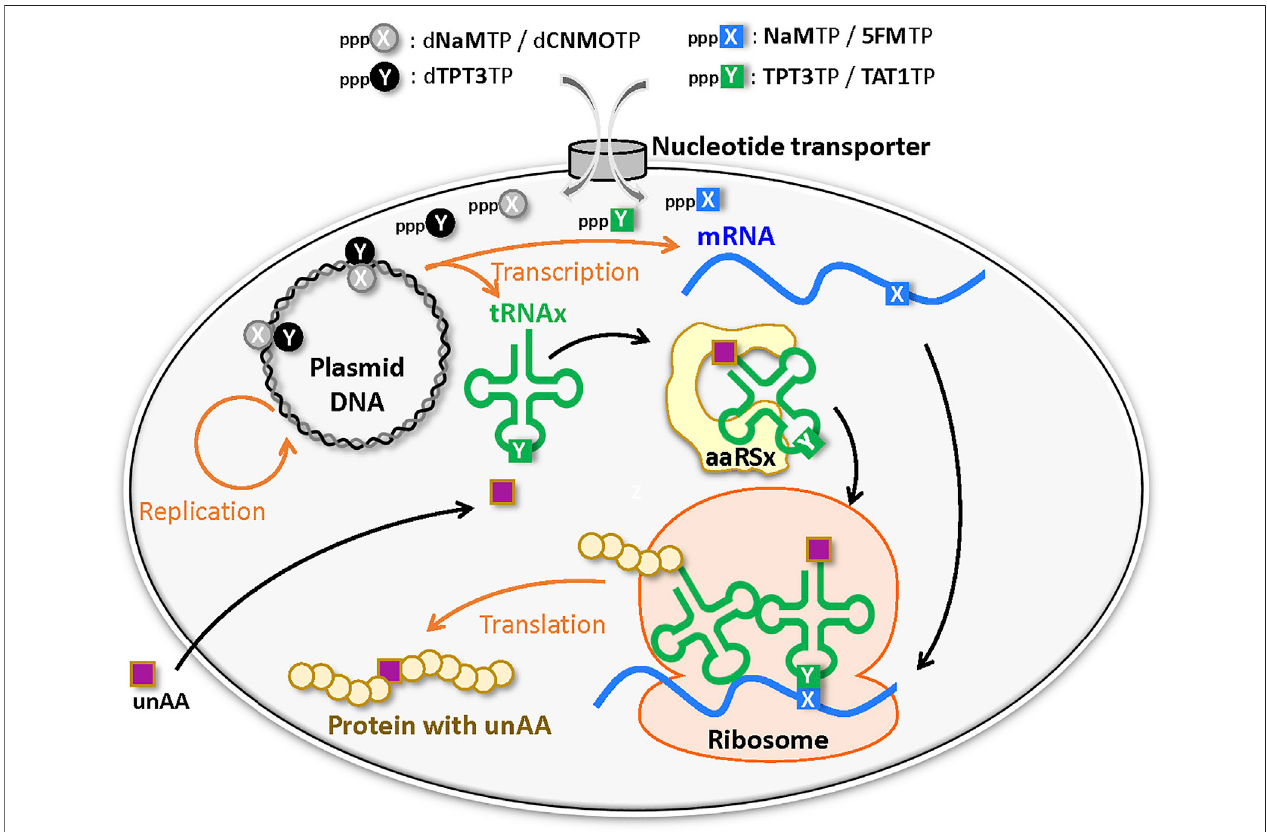
FIGURE 5 | Semi-synthetic organism (SSO) that stores and retrieves the six-letter genetic information expanded by an unnatural base pair (X – Y) system.